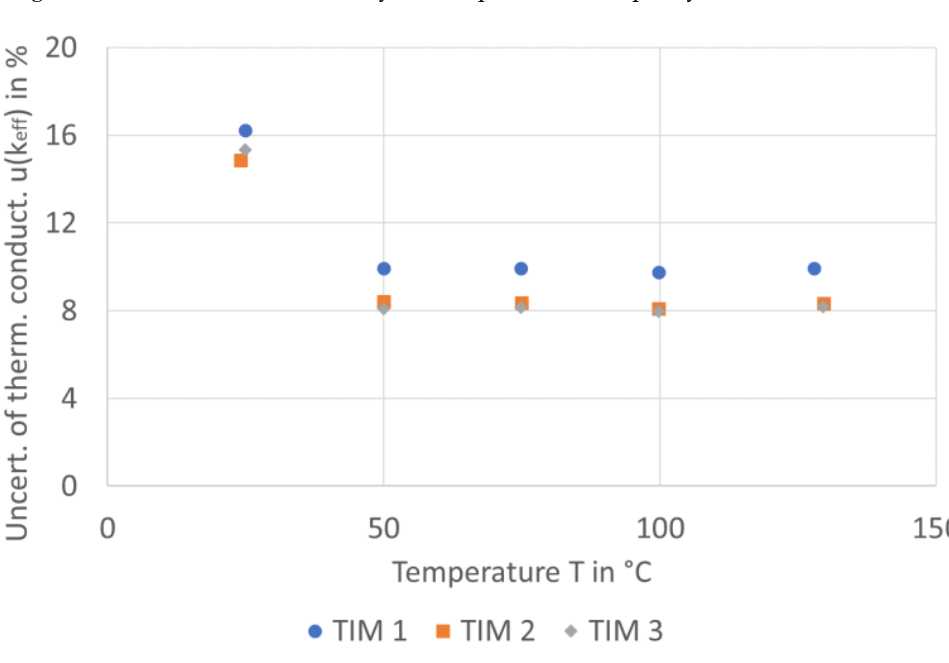
Figure 9. Uncertainty of thermal conductivity regarding every investigated